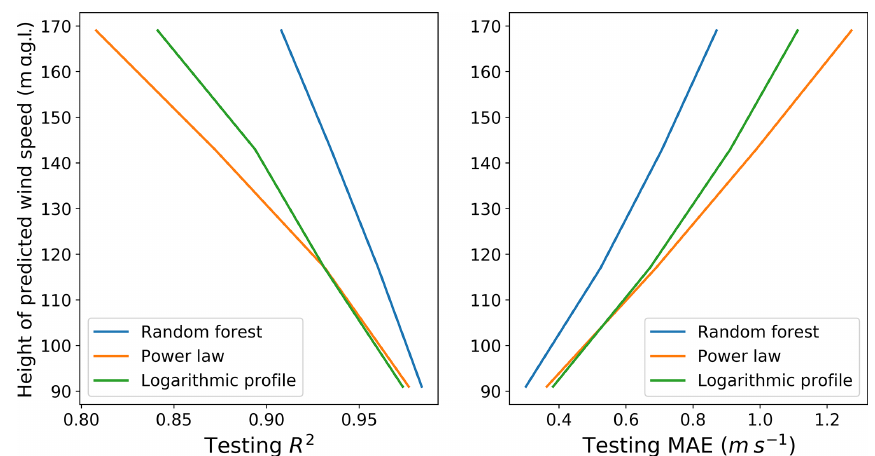
Figure 4. Testing R 2 and MAE as a function of the height of the extrapolated predicted wind speed, for the three considered techniques.